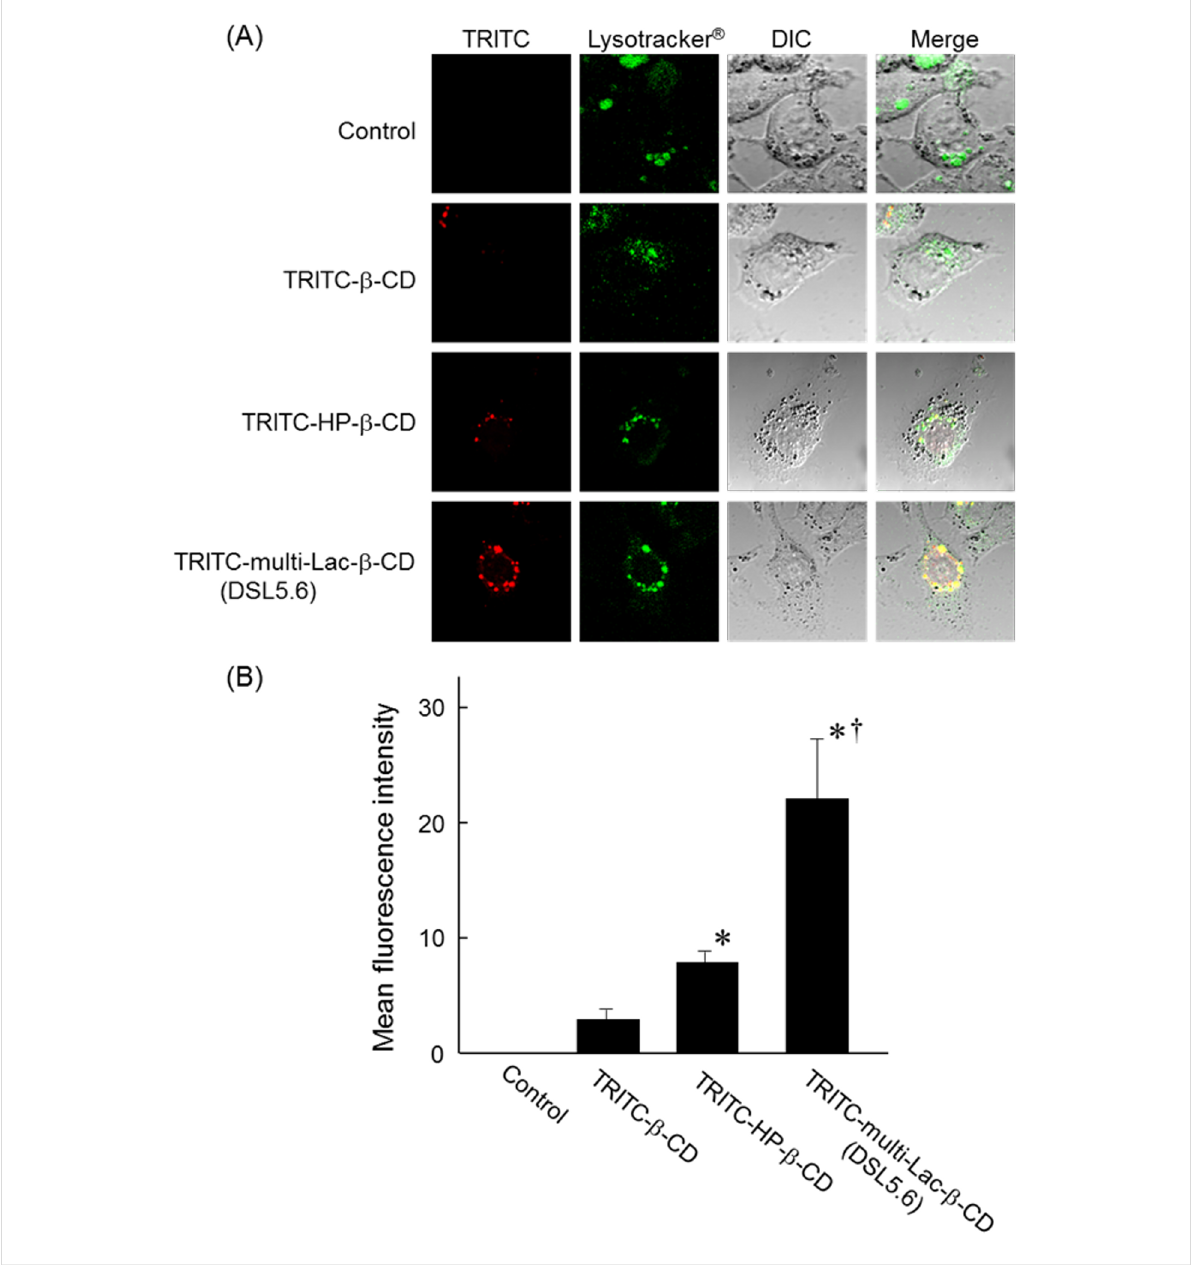
Figure 5: Intracellular distribution of TRITC-multi-Lac- β -CD (DSL5.6) in NPC-like HepG2 cells. Cells were incubated in medium [FBS ( − )] with or with- out 100 μ M TRITC-CDs for 24 h. (B) The fluorescence intensities of TRITC-CDs were determined in ten randomly selected cells per image by confocal laser scanning microscopy and BZ-II analyzer. Data represents mean ± S.E.M. of three experiments. *p < 0.05, compared with TRITC- β -CD. † p < 0.05, compared with 100 μ M TRITC-HP- β